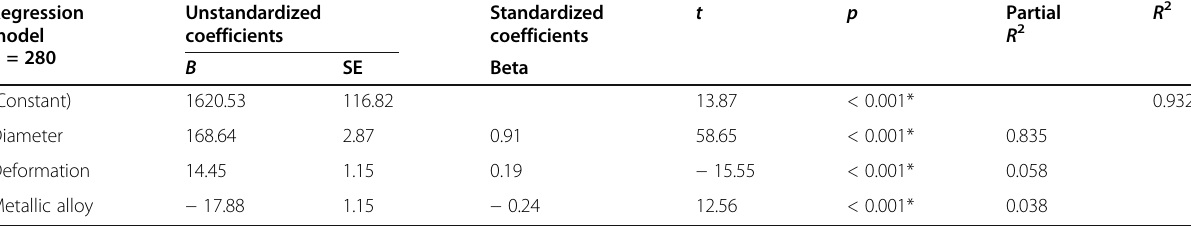
Table 4 Influence of MI diameter, deformation, and metallic alloy on the flexural strength (multiple linear regression analysis) Regression